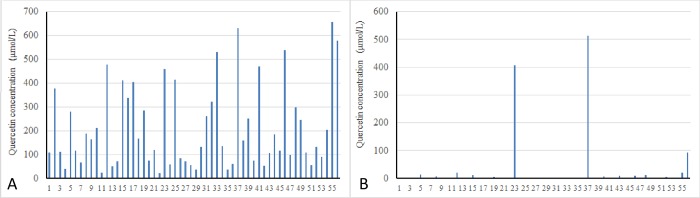
Quercetin concentration in fecal samples (A, B). Quercetin was anaerobically incubated with fecal suspensions for 7 h (A) or 24 h (B). N = 56. The X axis number indicates the volunteer number.